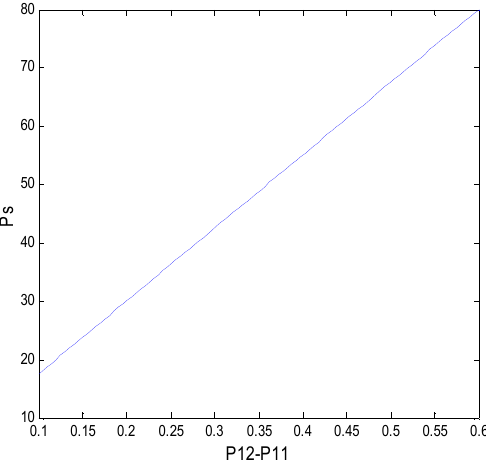
Figure 18. The effect of the expected return difference on the technological transaction prices.